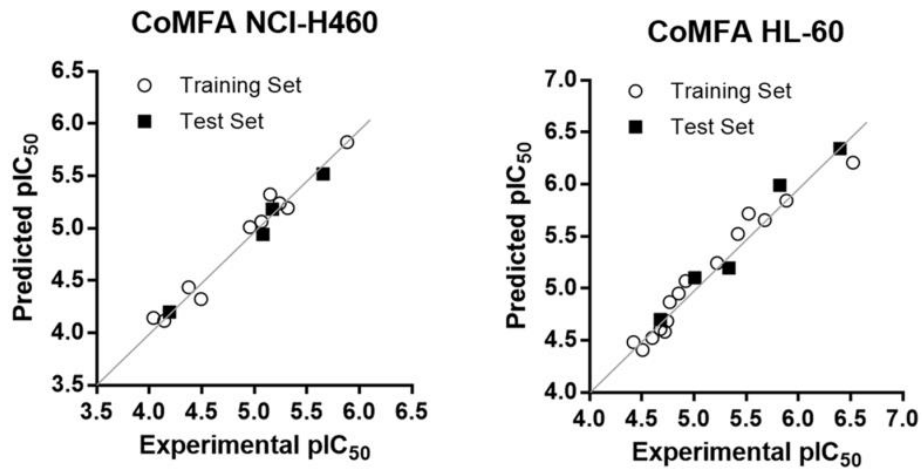
Figure 4. Plots of experimental versus predicted pIC 50 values for the training set and test set molecules